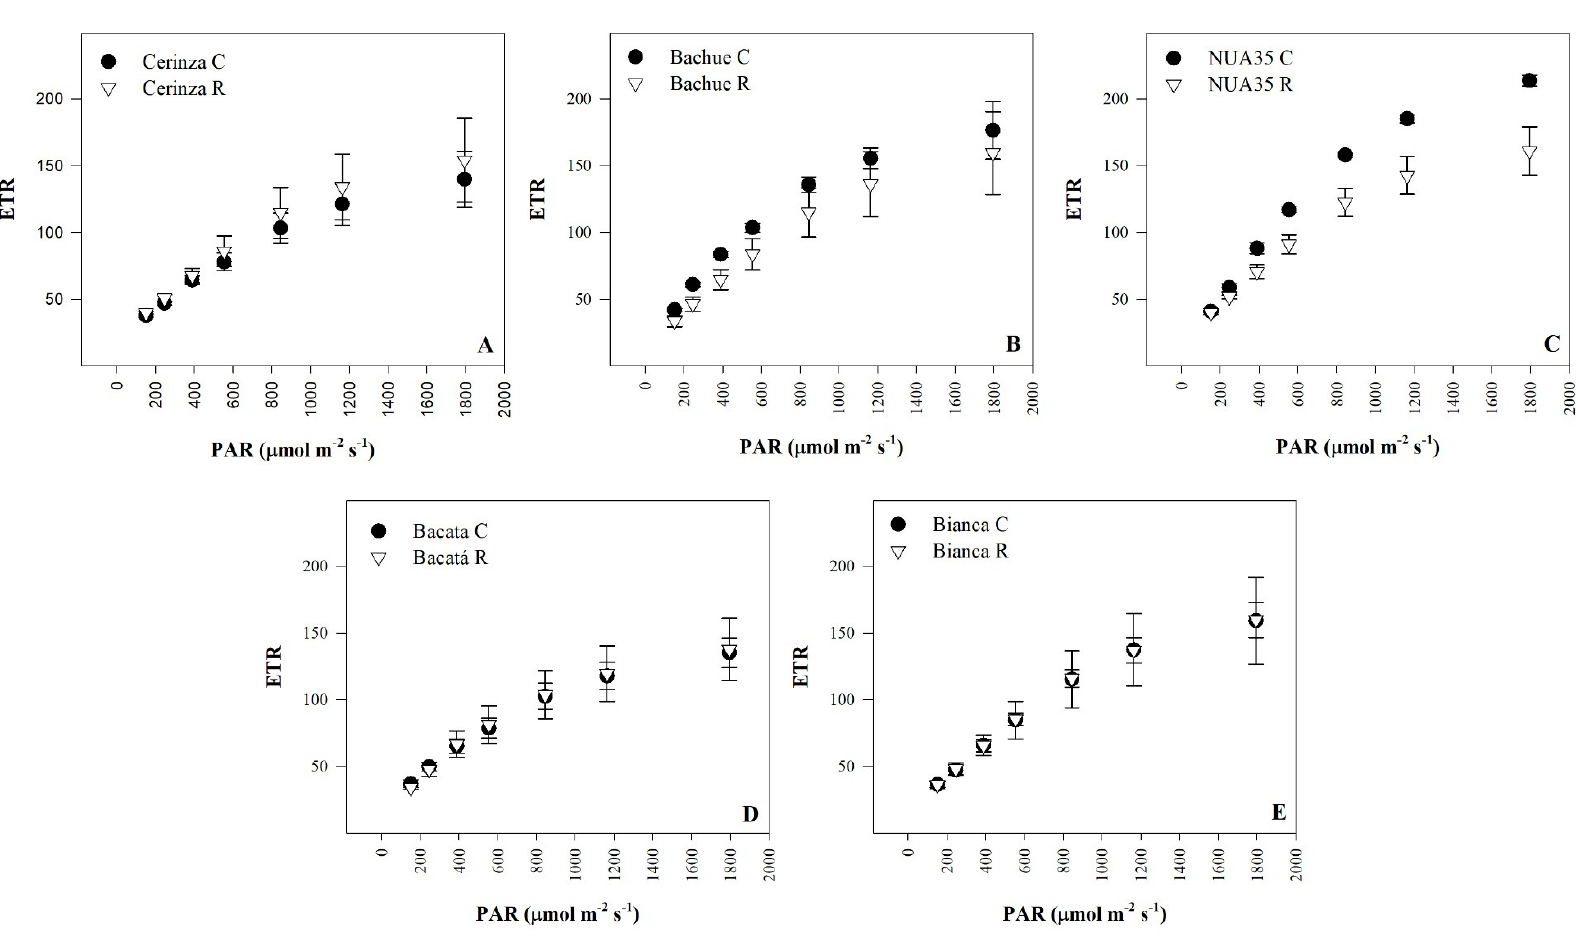
Figure 3. Electron transport rate (ETR) obtained from rapid light-response curves of ‘Cerinza’ ( A ), ‘Bachue’ ( B ), ‘NUA35’ ( C ), ‘Bacata’ ( D ) and ‘Bianca’ ( E ) under two water treatments (control ( (cid:8) ) and water-stressed ( (cid:53) ) plants) at the end of reproductive stage (65 DAE). Data represent the mean of four data points ± standard error.